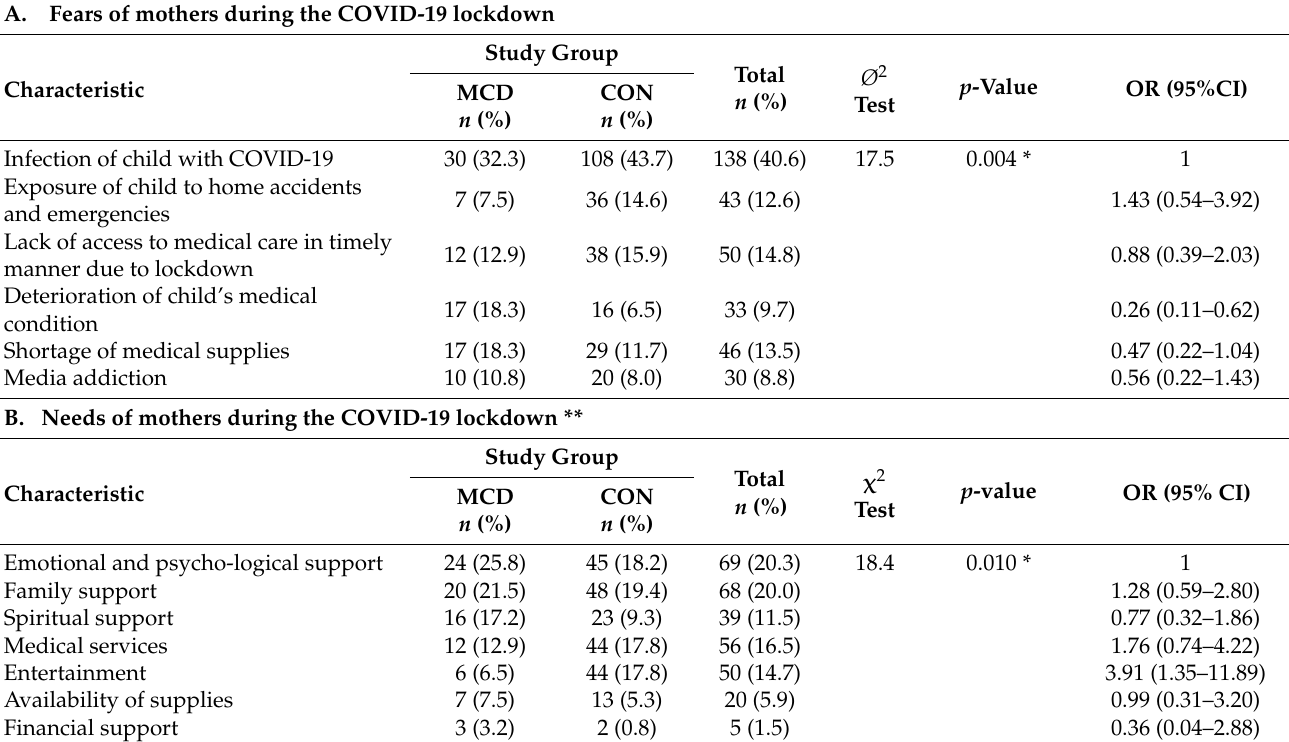
Table 6. Fears and needs of mothers during the COVID-19